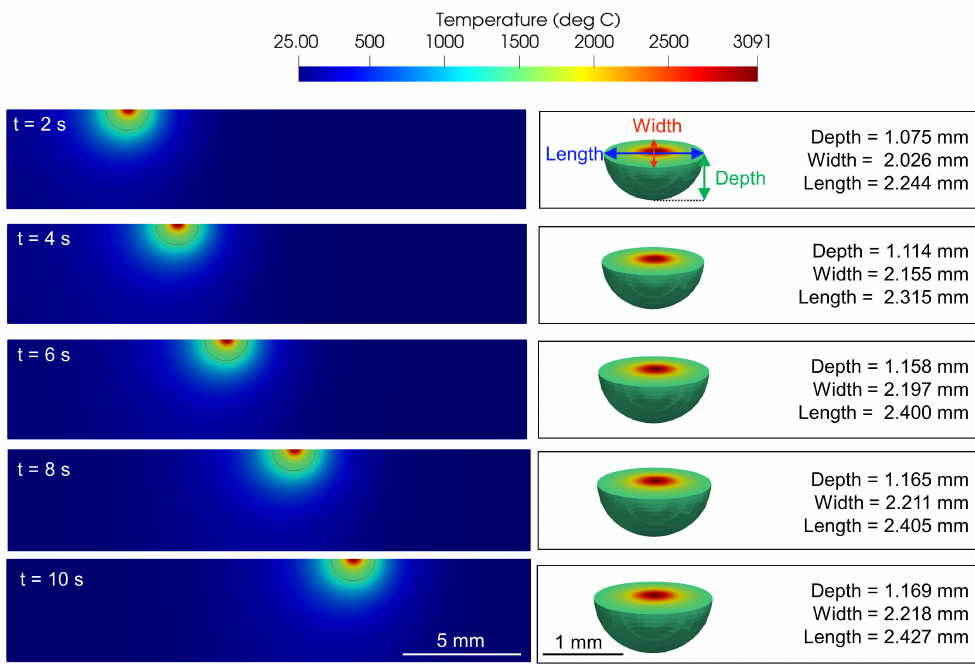
Figure 7. ZX cross section of the model simulations and the corresponding extracted isovolume to its right, showing the temporal variation of melt pool dimensions P of 1000 W and scan velocity v of 1